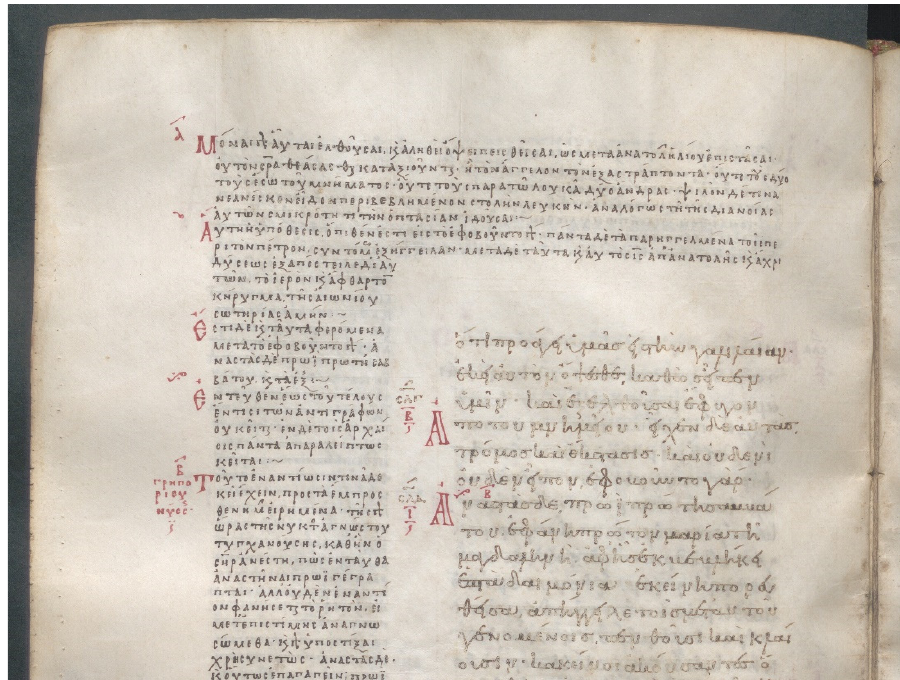
Figure 5. GA 1422 f. 178 v Lines 6–11 have the Shorter Ending introduced as an argumentum in the catena section. The Long Ending appears in the biblical lemma, given a new section number 234 assigned to Table 10. Copyrights: The National Library of the Czech Republic XXV B 7.